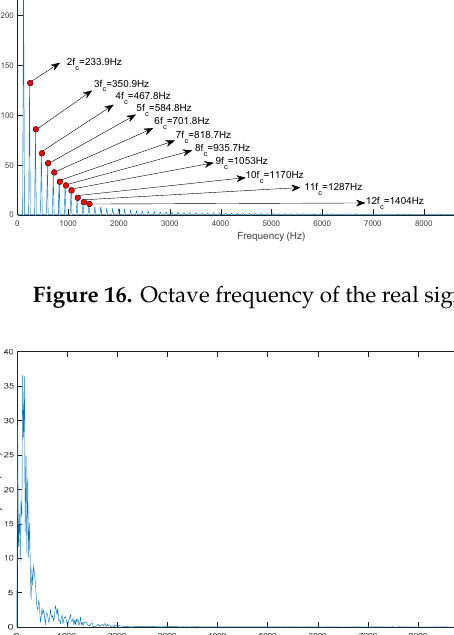
Figure 17. Envelope spectrum of the fourth IMF (IMF4).